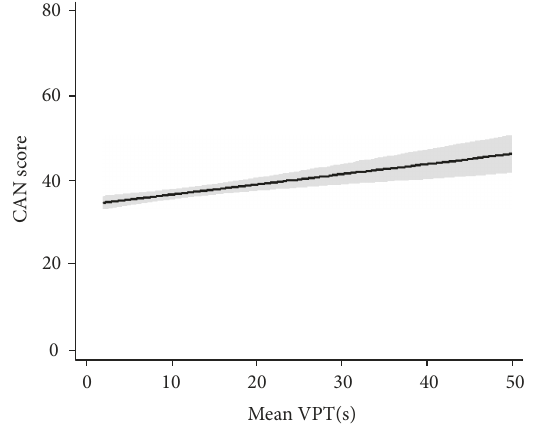
Figure 2: Adjusted regression curves showing the association between CAN score and the mean VPT value. Shaded area represents con fi dence intervals